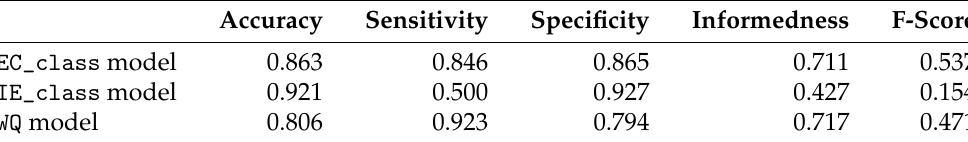
Table 9. Various metrics for EC_class , IE_class , and WQ